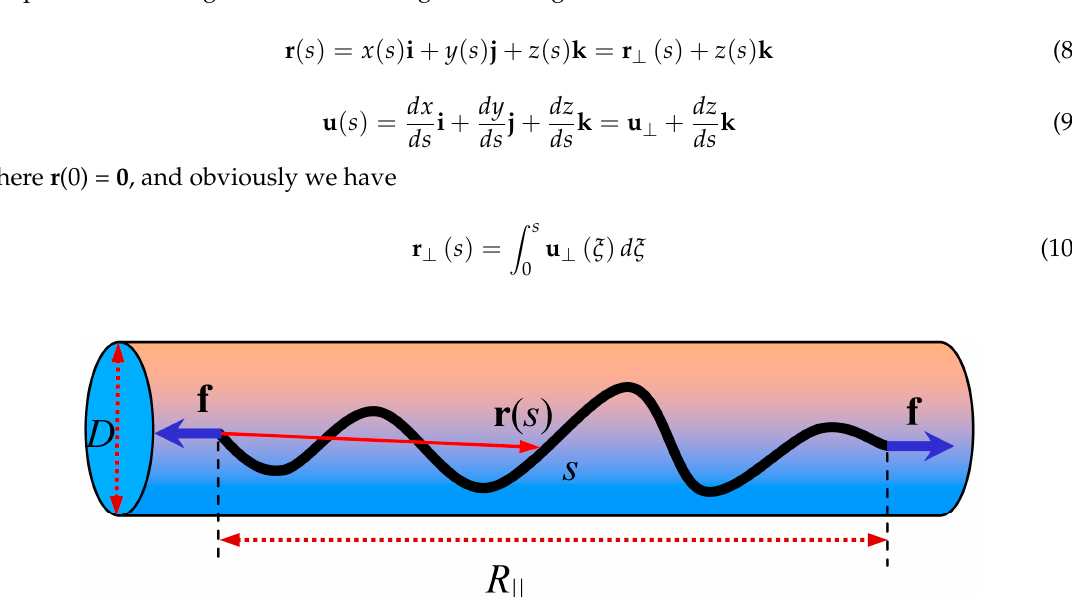
Figure 1. Schematic of a WLC confined in a tube and stretched by a force.